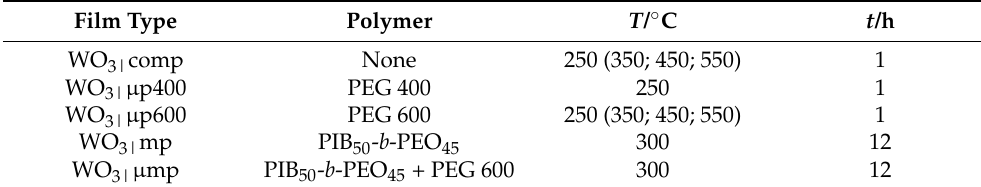
Table 1. Preparation conditions (utilized structure-directing agent, calcination temperature T and duration of calcination t ) of different tungsten oxide thin films used for the spectroelectrochemical